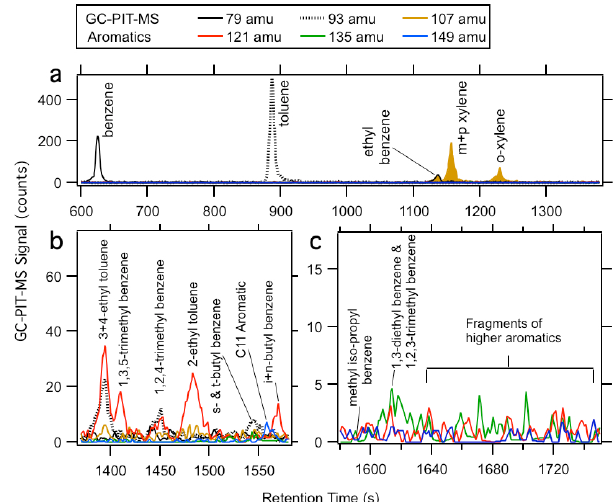
Figure 4. GC-PIT-MS chromatograms for aromatic measurements from 600-1400 seconds (a), 1300-1001 Fig. 4. GC-PIT-MS chromatograms for aromatic measurements 1580 seconds (b) and 1580-1750 seconds (c). Identifications made after 1300 seconds retention time 1002 from 600–1400s (a) , 1300–1580s (b) and 1580–1750s (c) . Iden- are more uncertain than those for the C6-C8 aromatics. 1003 tifications made after 1300s retention time are more uncertain than those for the C6-C8